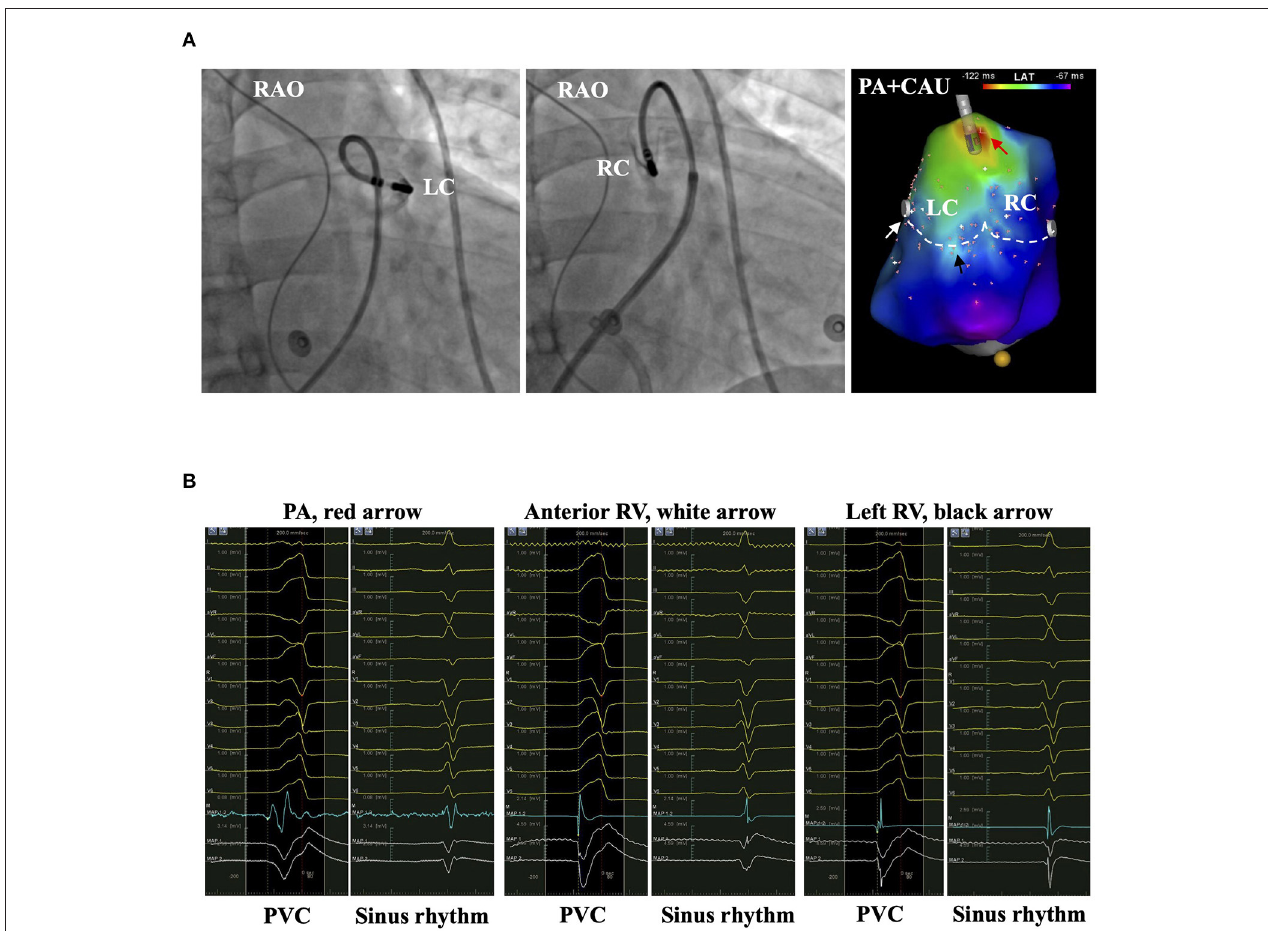
FIGURE 9 | The representative patient with PVC originating from PA. (A) The left and middle panels show the bases of LC and RC by injecting contrast from the irrigation tube of the catheter. The right panel shows the activation mapping. The white dashed line denotes the PVVJ. The red arrow marks the EVA site 18.6mm above PVVJ. White and black arrows mark the relative early ventricular activation site at the anterior and left RV. (B) The panels show the electrograms in PVC and sinus rhythm recorded at the arrow-denoted sites from left to right. The red dashed line denotes the time point of reference. The yellow dashed line denotes the LAT. EVA, earliest ventricular activating; LAT, local activating time; LC, left cusp; PVC, premature ventricular contraction; PVVJ, pulmonary valve–ventricle junction; RC, right cusp.